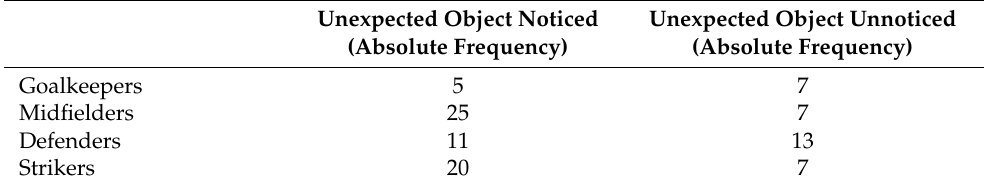
Table 3. Rates of noticing the unexpected object (absolute frequency) per